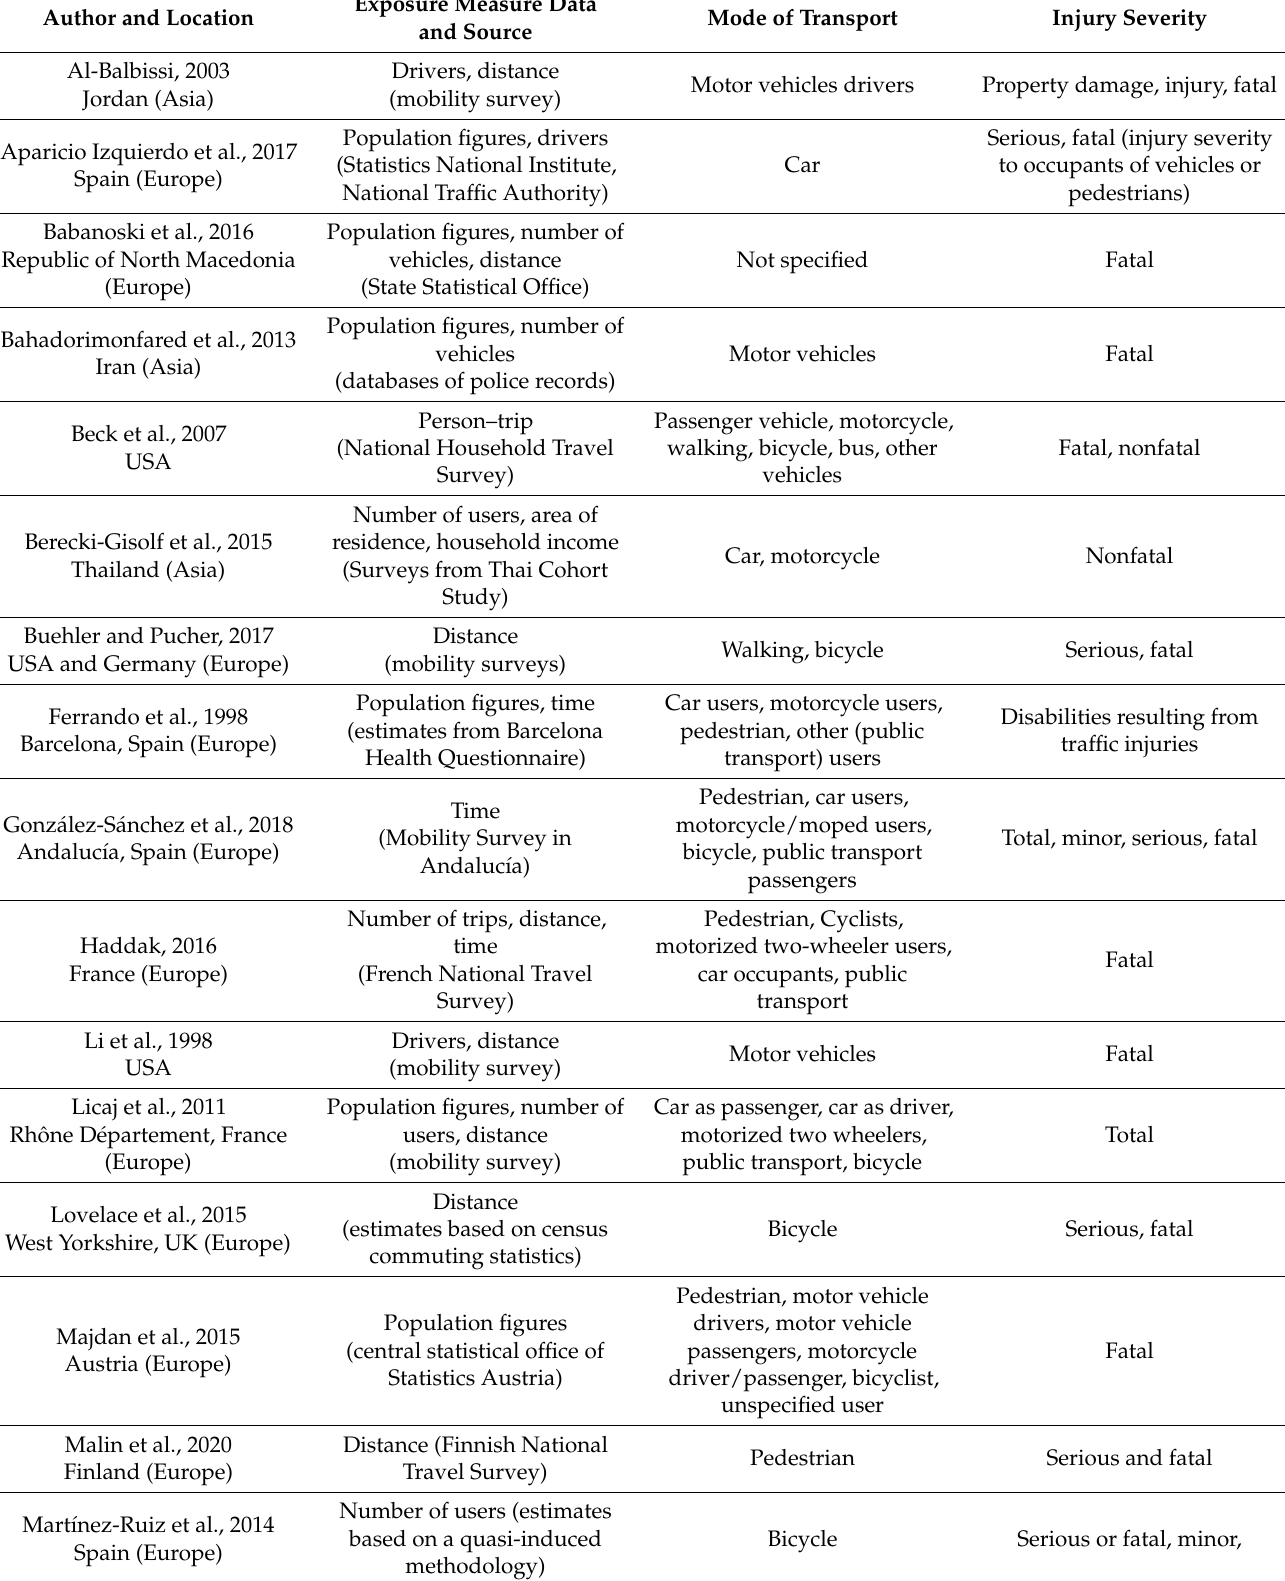
Table 1. Empirical studies on traffic accidents with reported exposure